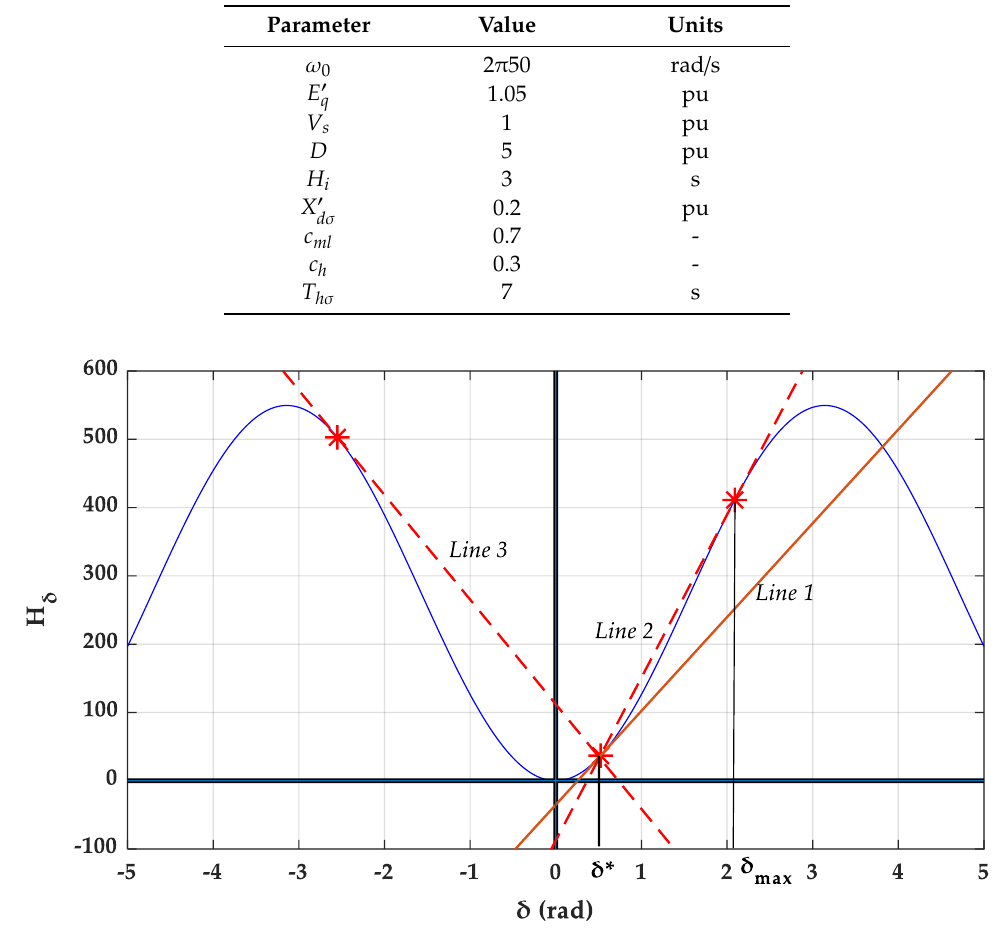
 () H explaining the distance measure application on RoA evaluation. Figure 1. The geometry of Figure 1. The geometry of H δ ( δ ) explaining the distance measure application on RoA 